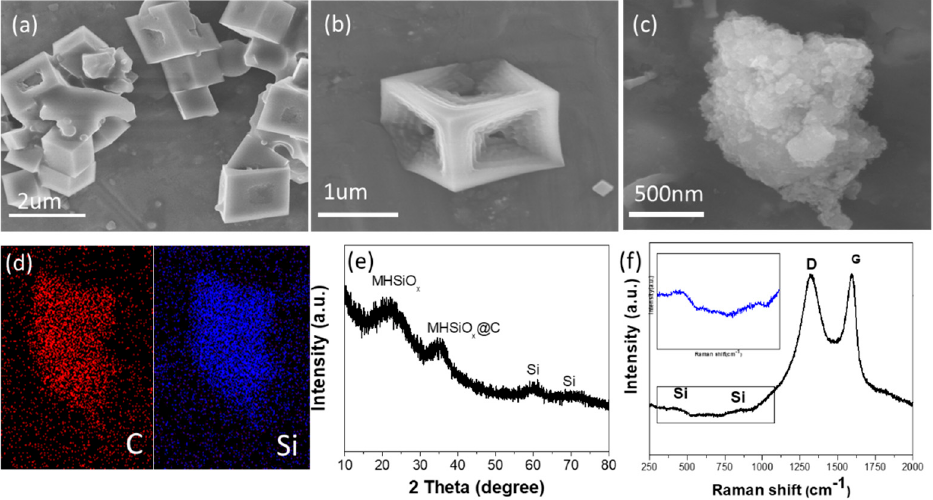
Figure 2. ( a , b ) Scanning electron microscope (SEM) images of poly(POSS-styrene) at different magnification. ( c , d ) SEM image and elemental mapping of Si@C. ( e ) X-ray diffractometer (XRD) patterns of Si@C. ( f ) Raman spectra of Si@C.